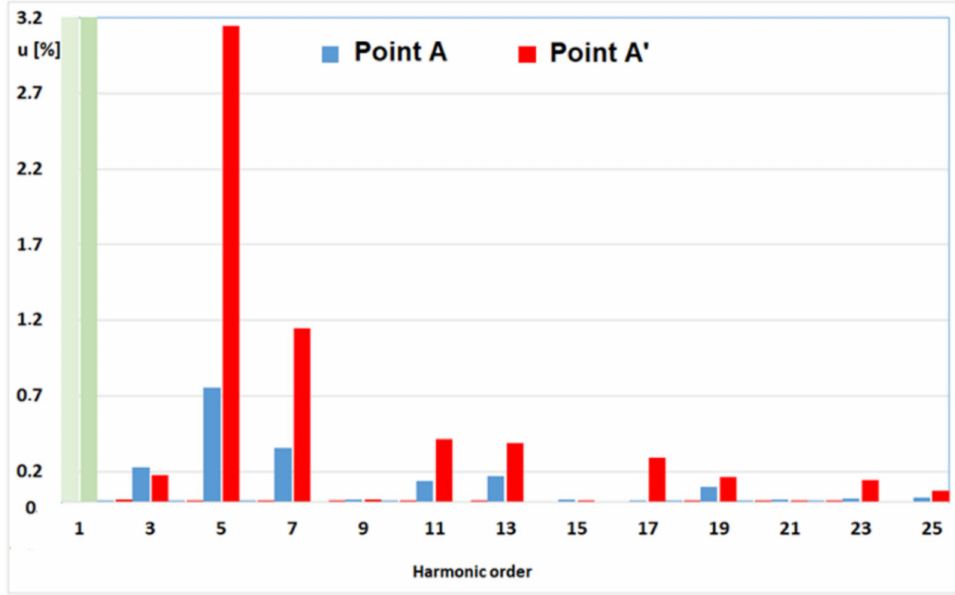
Figure 9. Spectrum of voltage harmonics—point A and point A (cid:48)